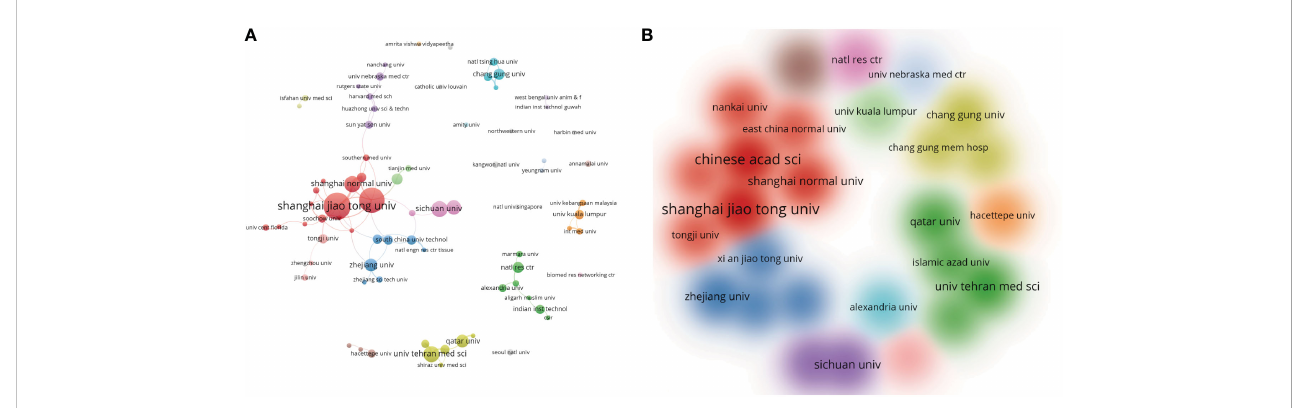
FIGURE 5 VOSviewer network map of institutions (A) ; Density distribution map of institutions (B) . Minimum number of articles published by the institution was set to